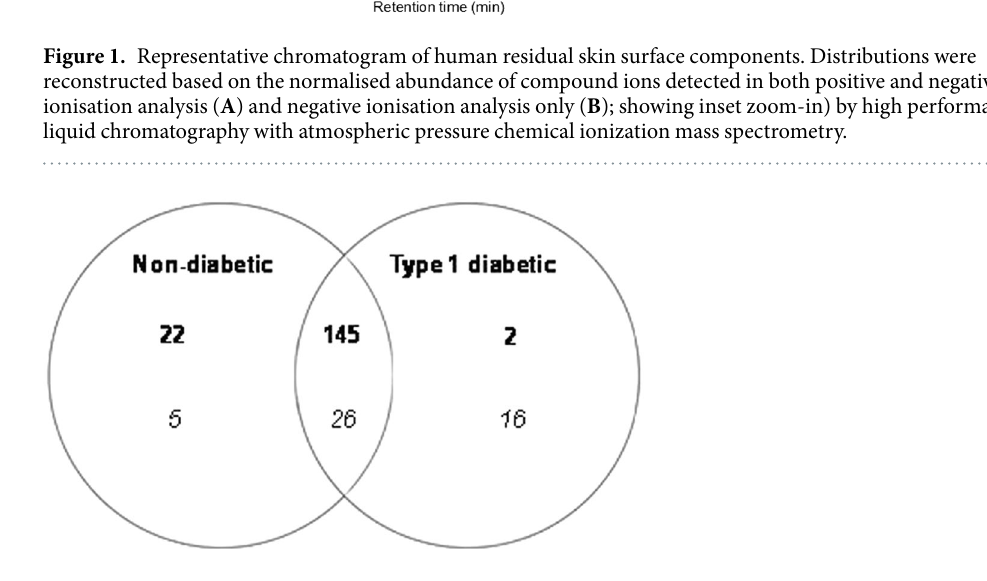
Figure 2. Commonalities and differences in the number of compound ions detected in positive ionisation (bold) and negative ionisation (italics) mode between type-1 diabetic (n = 44) and non-diabetic (n = 58) residual skin surface component